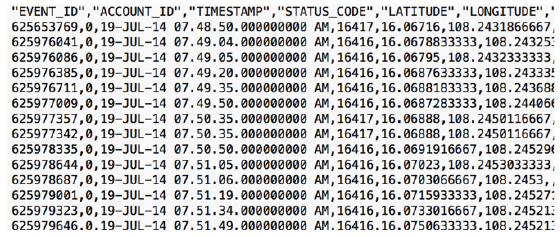
Fig.1. An example of GPS Log